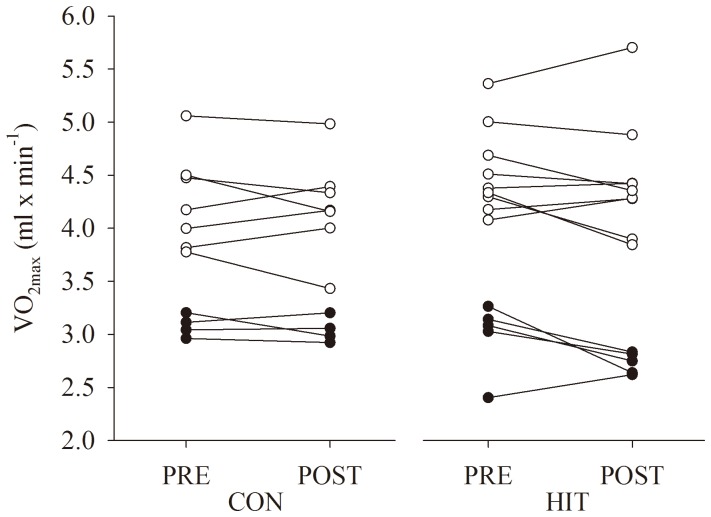
Oxygen uptake.Maximal oxygen uptake (VO2max) determined during freestyle swimming in a swimming flume with increasing water speed until exhaustion in two groups of swimmers before (PRE) and after (POST) a training intervention. One group performed usual swim-training (CON) and another group reduced their training volume by 50% and more than doubled the amount of high-intensity training (HIT). On average, VO2max was similar before and after the 12 week intervention period in both groups. Individual data is presented. Open circles: male; Closed circles: female.